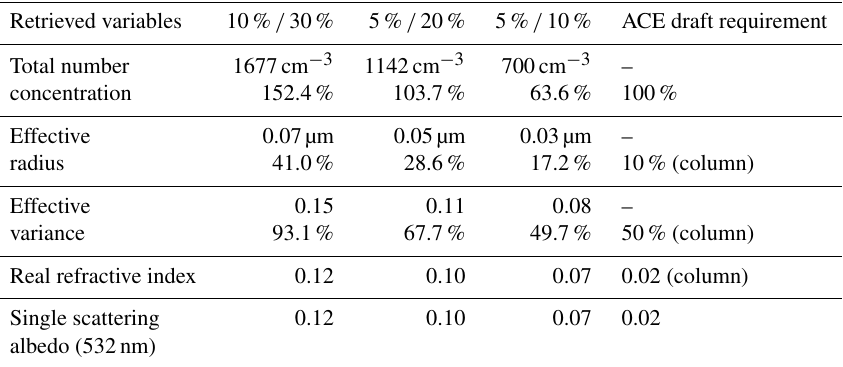
Table 4. Propagated uncertainties for Case 1, expressed as absolute values and percentage (for the size distribution parameters) for three different theoretical instrument configurations with different backscatter and extinction uncertainties. The last column repeats the draft requirements from the ACE white paper as in Table 3 for